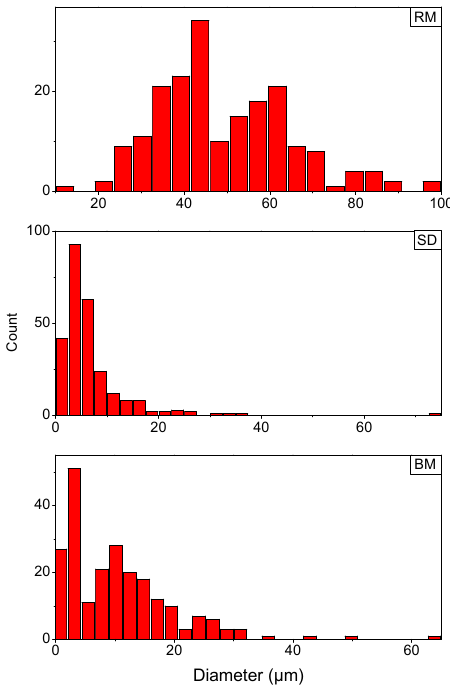
Figure 4. PSD of the differently processed sPS samples. RM depicts the rotor-milled sample ( top ); SD depicts the spray-dried sample ( middle ); and BM the ball milled sample ( bottom ).